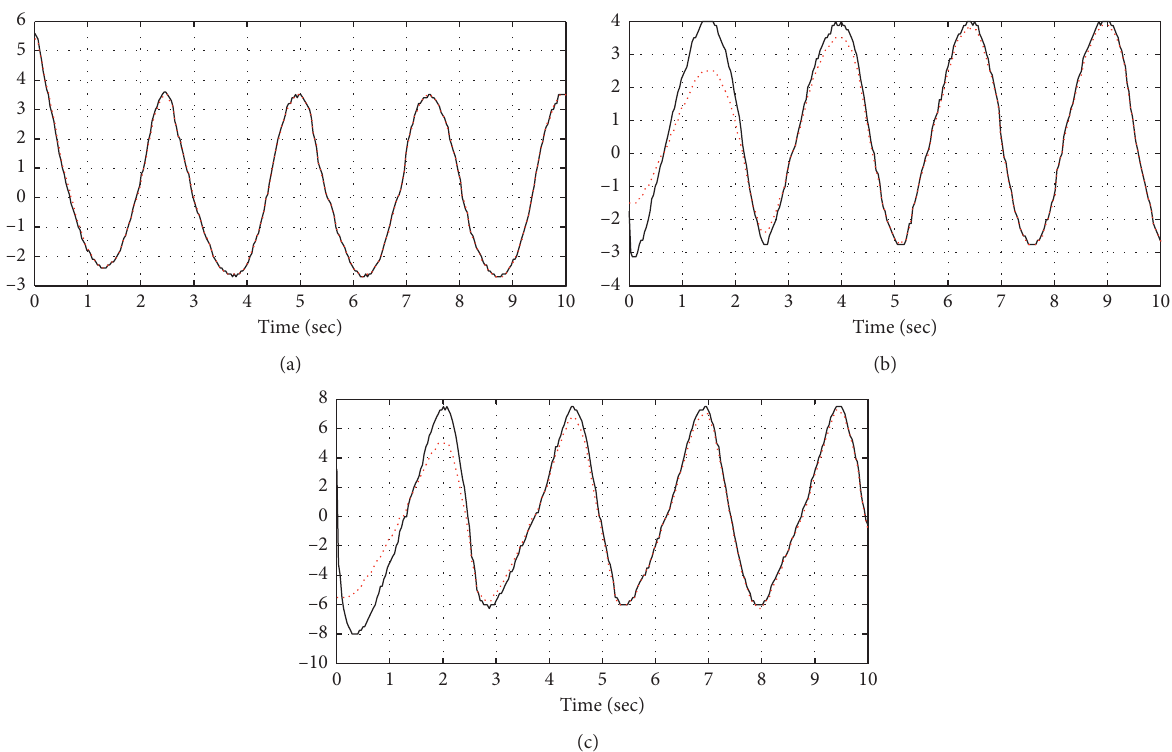
Figure 8: Observation process for the implemented systems (true state, solid line; estimated state, dashed line) for (a) x 􏽢 x , and (c) x and. 􏽢 x 2 3 3